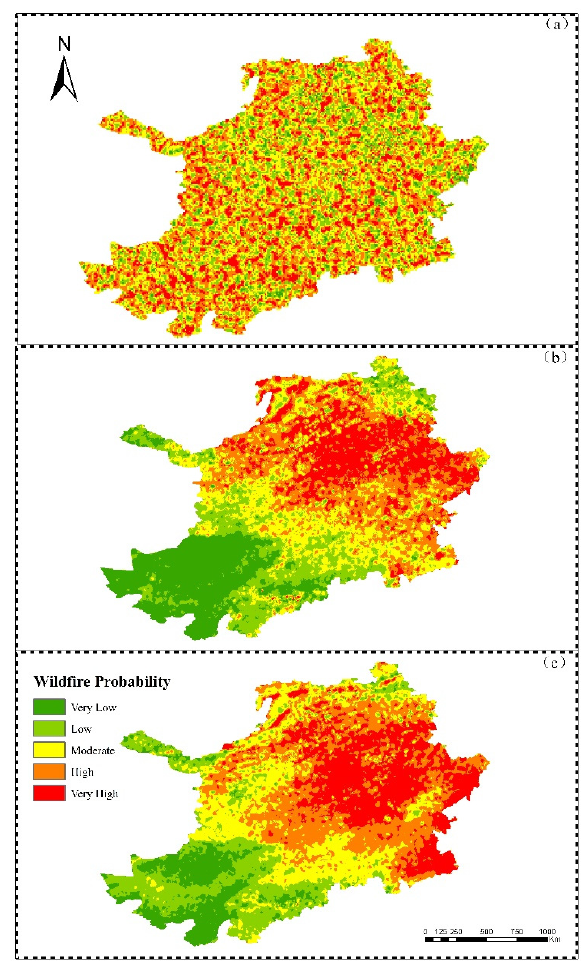
Figure 6. Probability map of wildfire occurrence generated by single ANFIS ( a ), PSO-ANFIS ( b ) and GA-ANFIS ( c ) model.